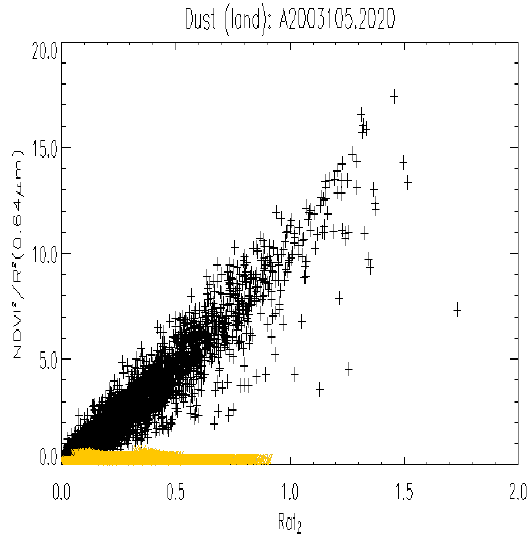
Figure 2. Scatter plot of MNDVI versus Rat crosses) pixels in Figure